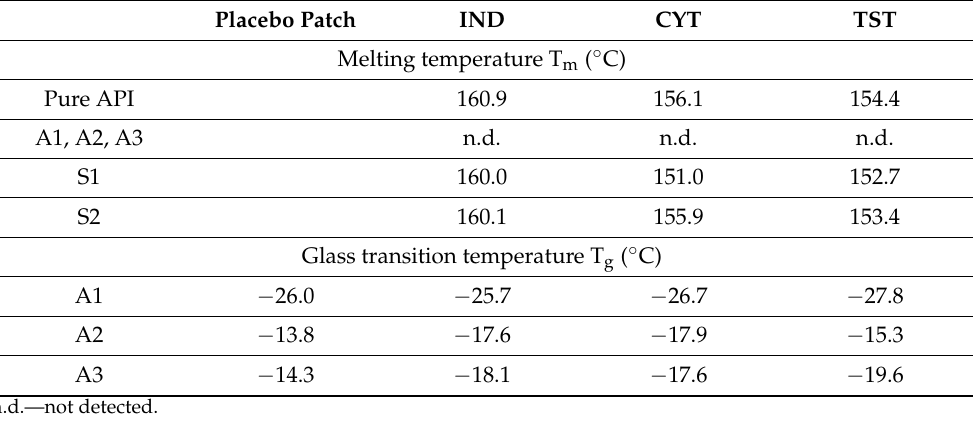
Table 5. Melting temperatures of API recorded in thermograms of the tested silicone patches and the effect of API on glass temperatures recorded for acrylic patches.